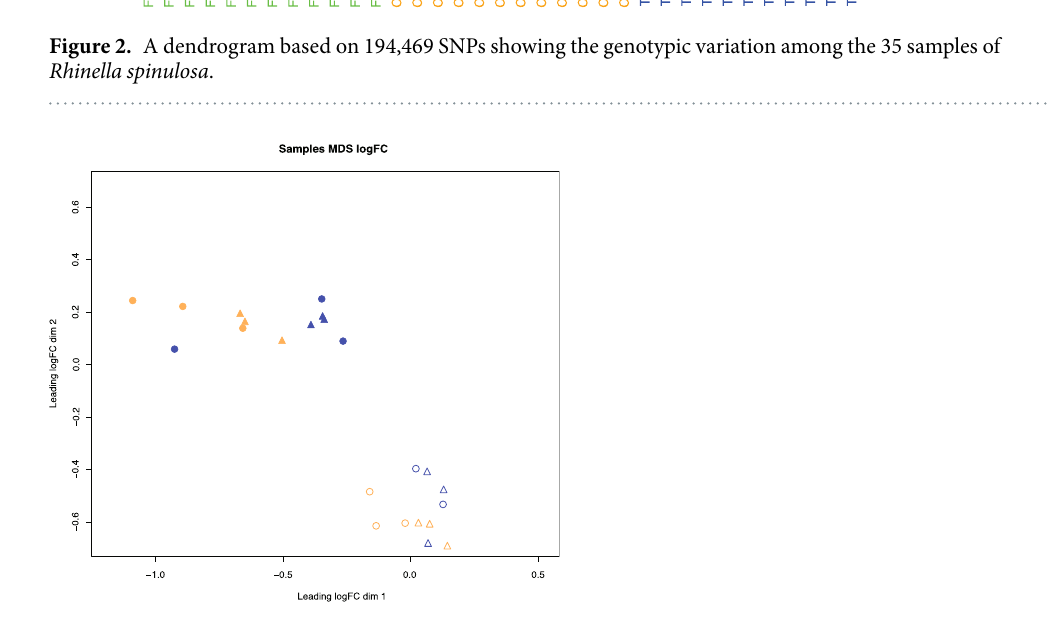
Figure 3. Multidimensional scaling (MDS) plot of the logarithm of fold-change (logFC) values for the most variable genes in the 35 assembled transcriptomes of Rhinella spinulosa . Symbols for El Tatio, Chile are shown in blue and Catarpe, Chile in orange. Circles correspond to treatment at 20 °C, and triangles to treatment at 25 °C; while the filled circles/triangles correspond to Gosner stage 36 and open circles/triangles to Gosner stage